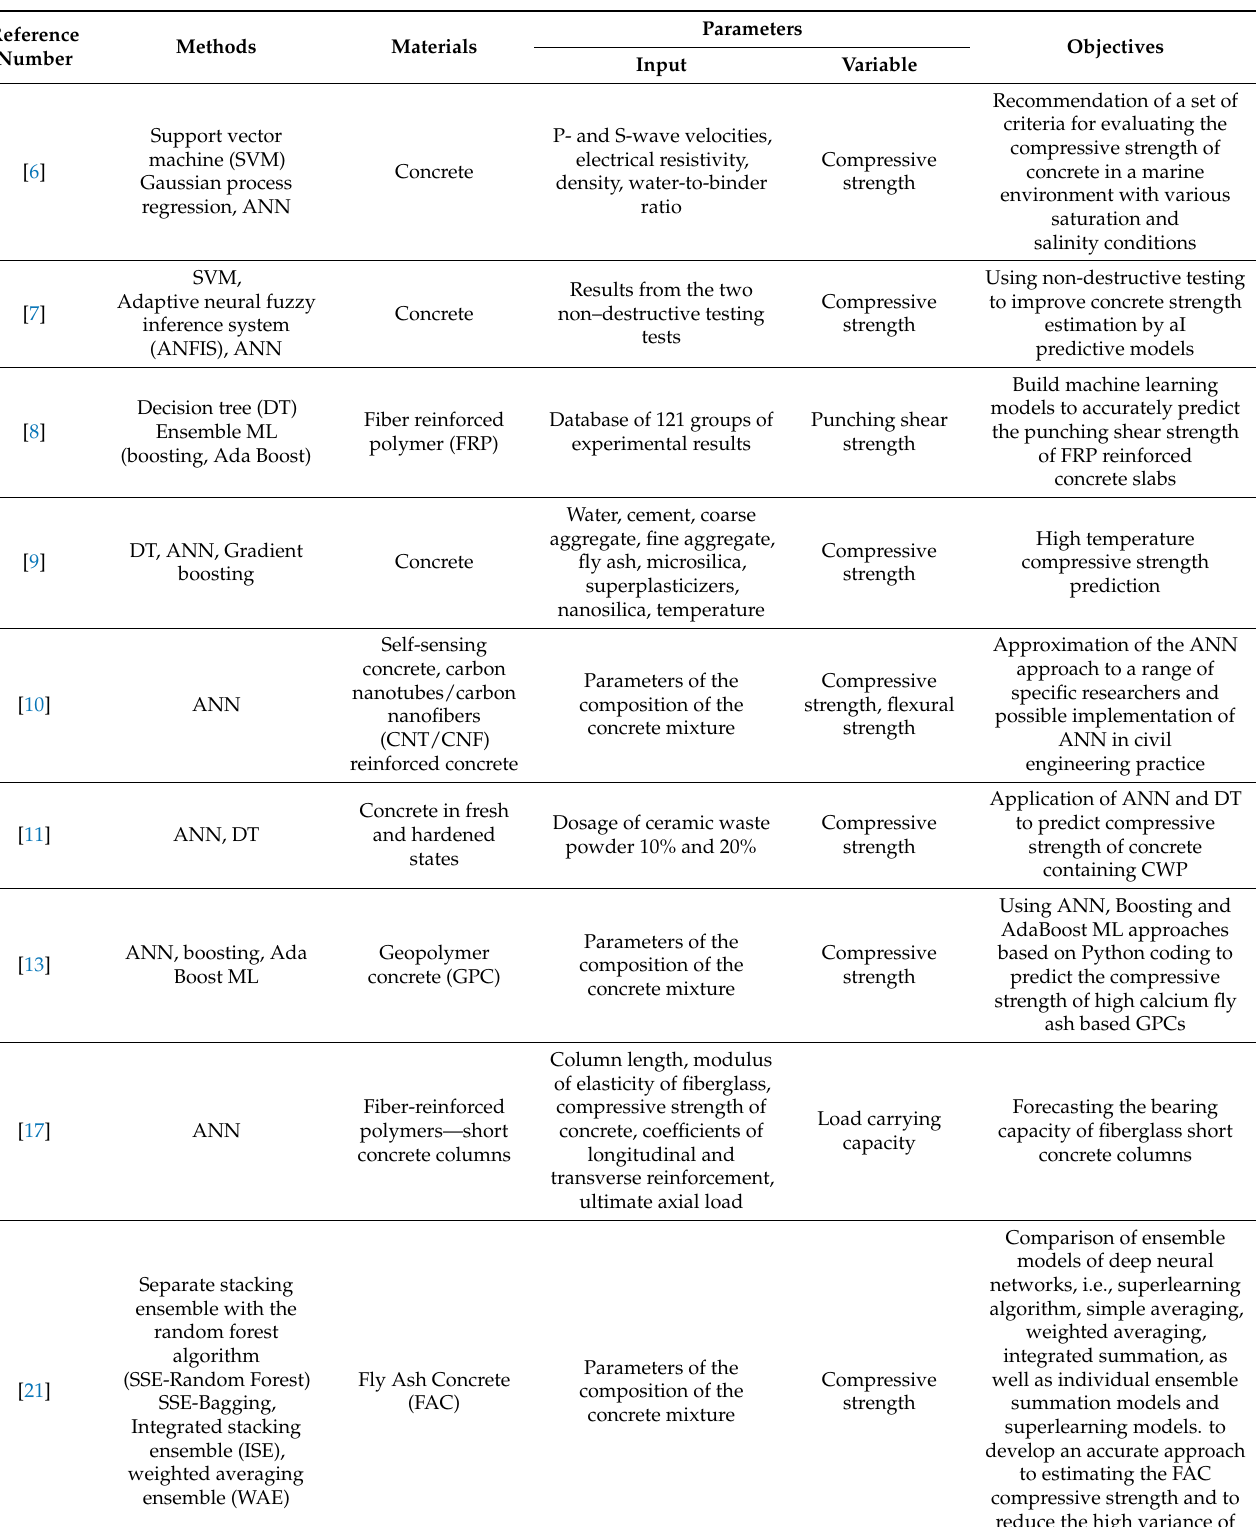
Table 1. An overview of the main artificial intelligence methods used to predict the properties of various types of